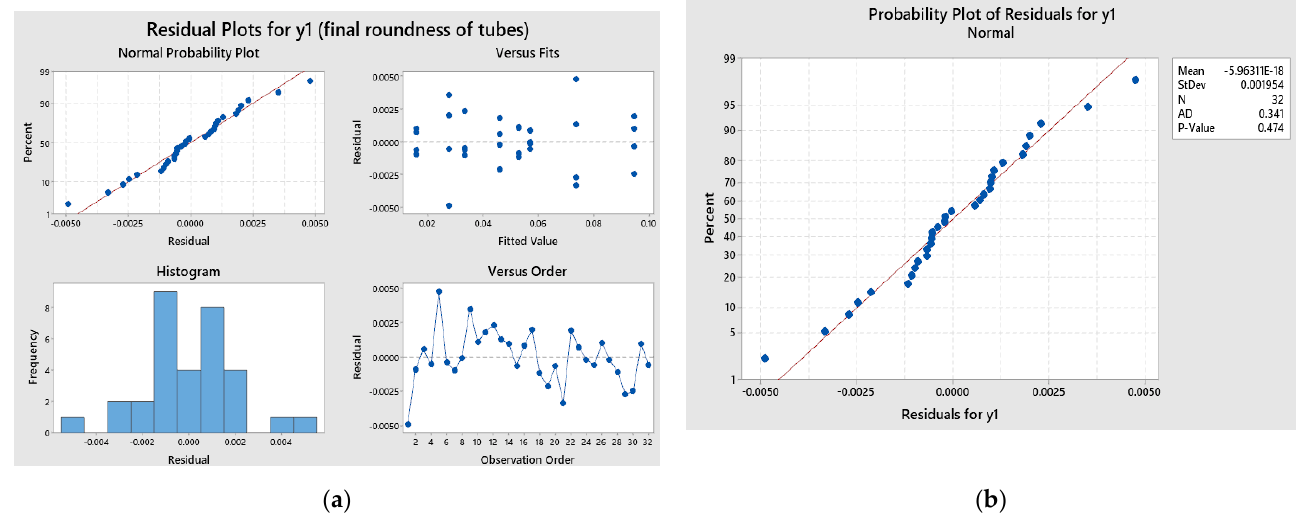
Figure 6. A closer look into the fulfillment of the ordinary least squares assumptions for the response variable y 1 (final roundness of the tube): ( a ) residual plots for y 1 ; ( b ) results of the Anderson–Darling test for normality for y 1.